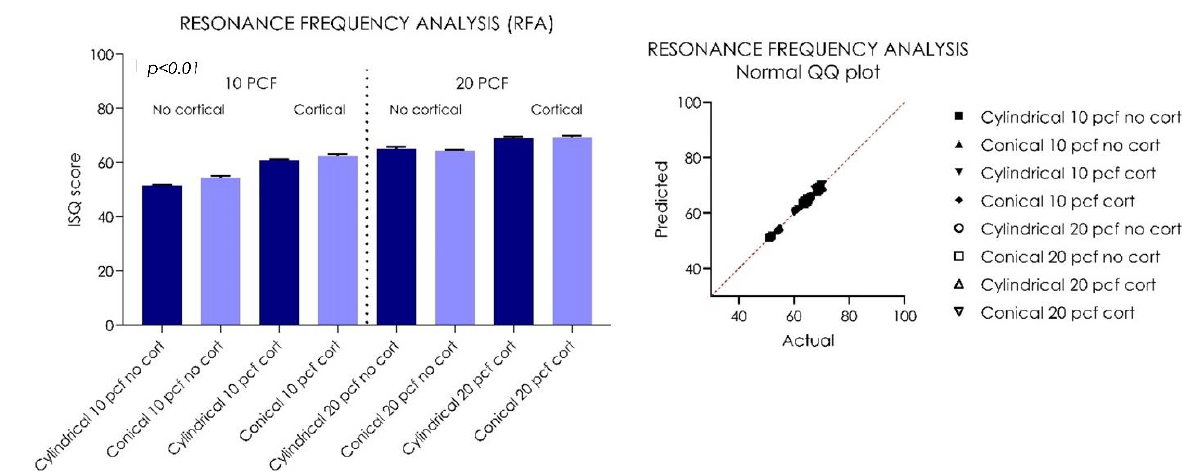
Figure 4. Graph and QQ plot values distribution showing the removal torque (RT) values of the tested cylindrical and tapered implants.